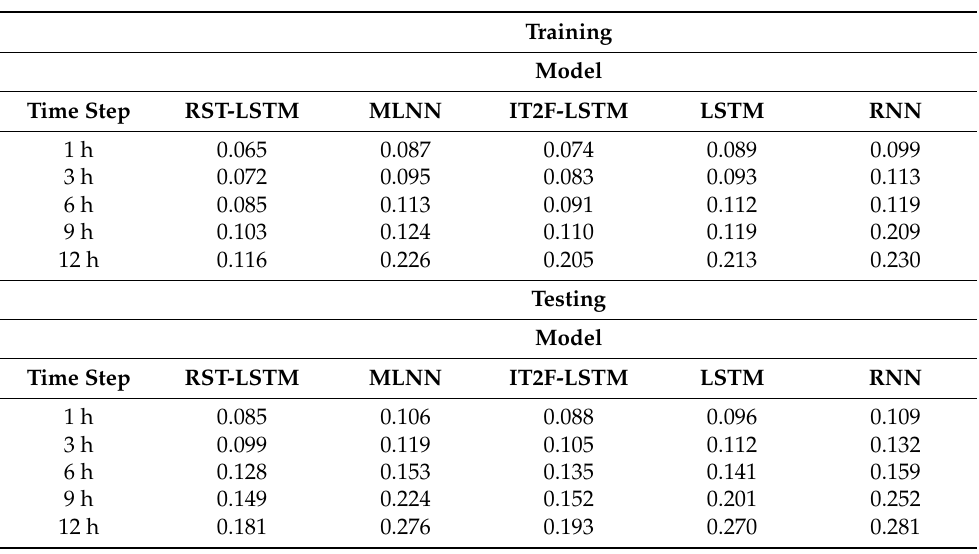
Table 2. RE (relative error) of training and testing datasets using forecasting approaches for different time